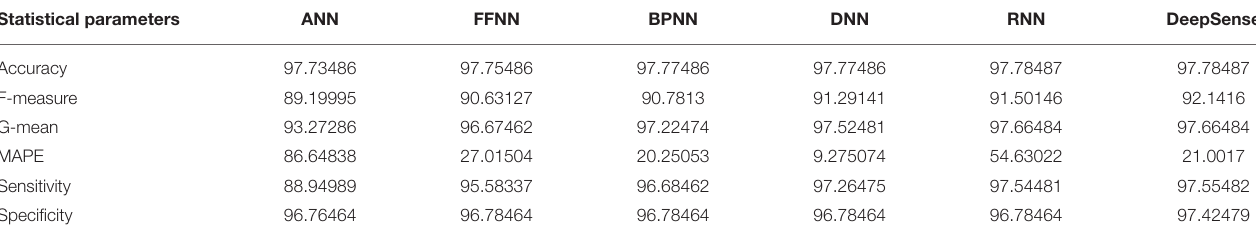
TABLE 6 | Results of statistical parameters for CORD-19 with 80% training data on 1,000 images. Statistical parameters